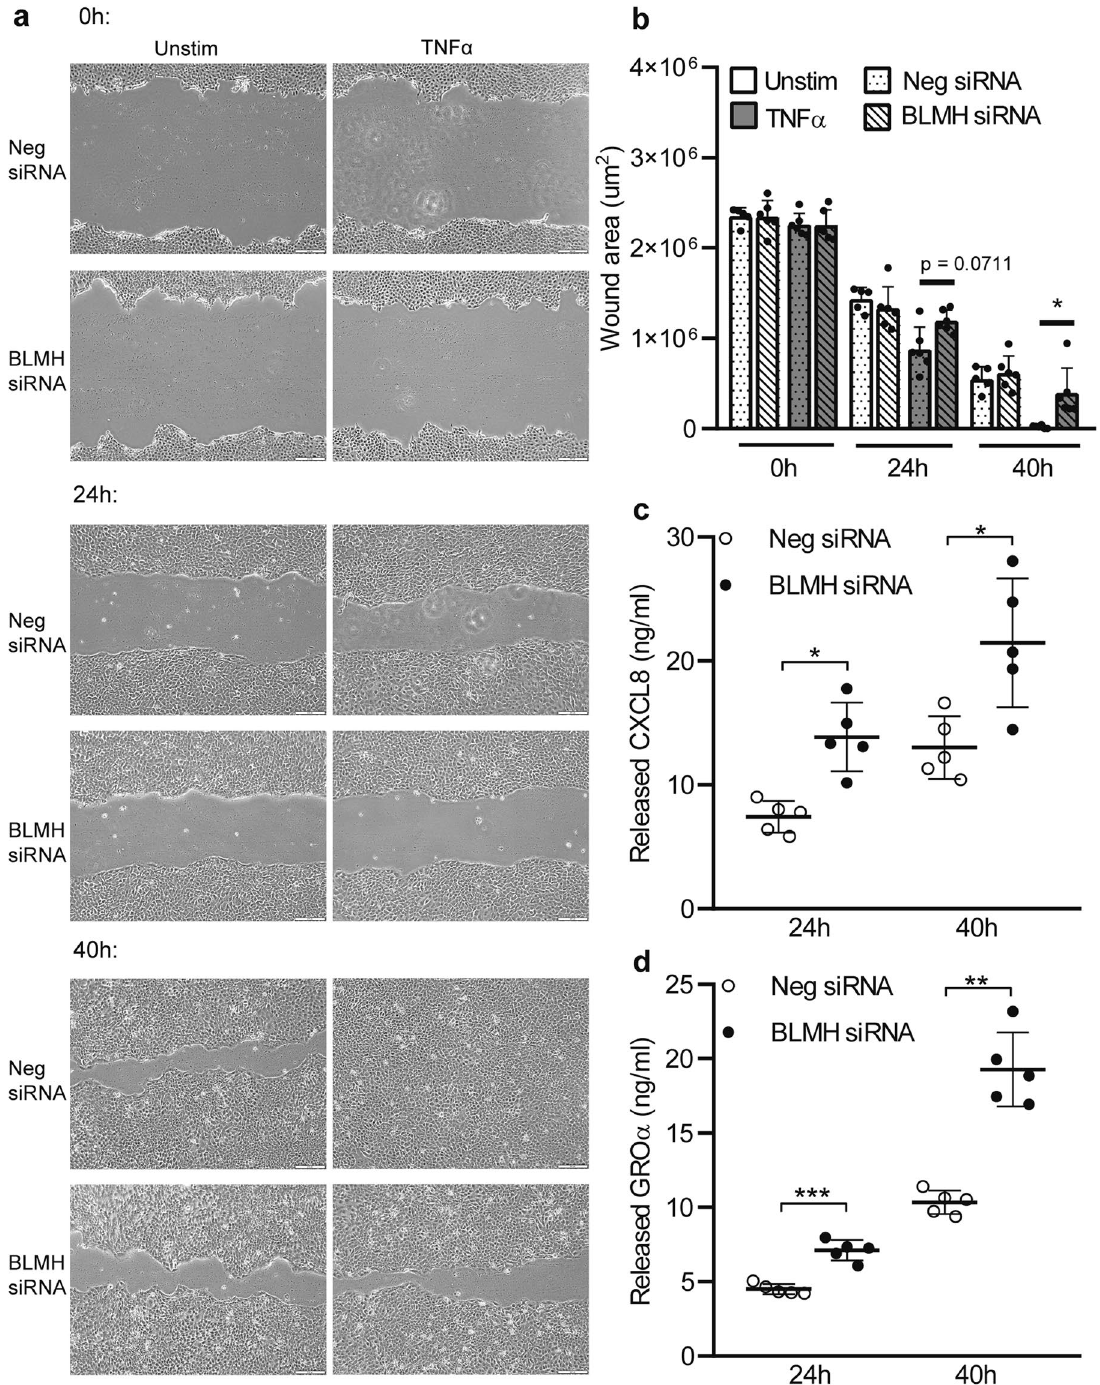
Figure 3. Knock-down of BLMH results in delayed wound healing. ( a,b ) Scratch wound assays were performed on monolayers of siRNA-transfected HaCaT cells and the wound area was analysed after 24 and 40 hours in presence or absence of additional TNF α (5 ng/ml) (n = 6, paired two-tailed Student’s t-tests). Scale bar shows 200 µ m. ( c,d ) Supernatants were collected from the scratch wounds after 40 hours and the levels of CXCL8 and GRO α were determined using ELISAs (n = 5, one-way ANOVAs with Sidak’s multiple comparisons test). All values represent individual experiments with mean ± standard deviation. Significant P-values are presented as * p < 0.05; ** p < 0.01; *** p < 0.001 and **** p <